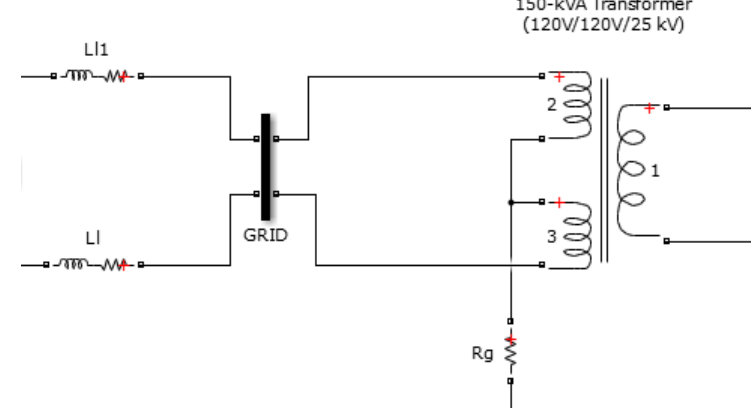
Figure 7. Model of the power transformer and the short low voltage line.